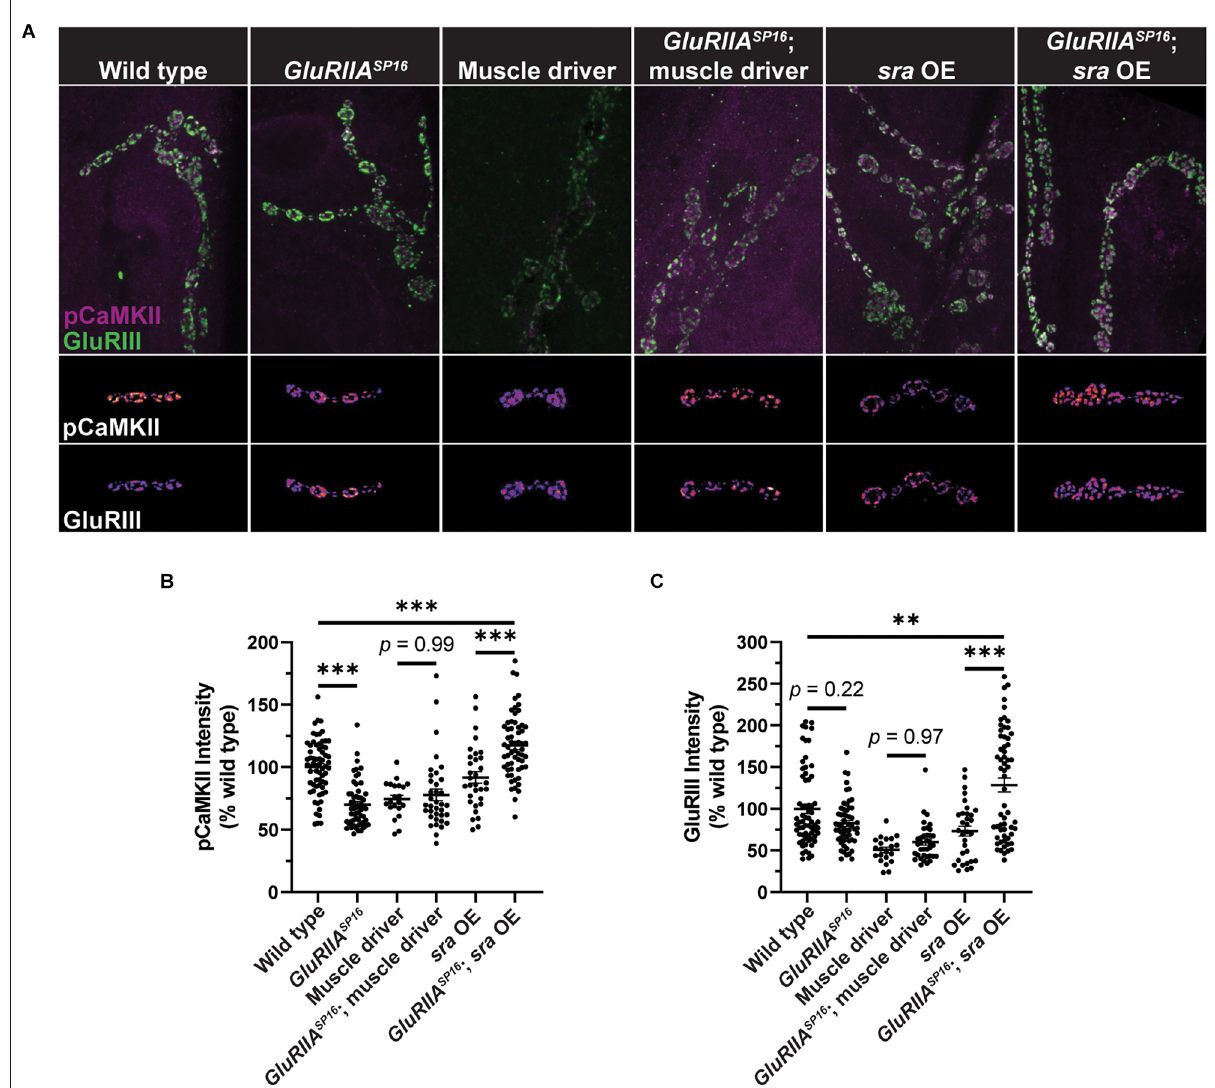
FIGURE6 Postsynaptic sra overexpression disrupts pCaMKII in Ib postsynaptic densities. (A) Maximum-intensity projections of pCaMKII (magenta) and GluRIII (green). Merged images of both channels are shown in the top row. Representative bouton maximum-intensity projections of pCaMKII (middle row) and GluRIII (bottom row) are shown as heat maps. (B) Quantification of pCaMKII intensity as a percentage relative to wild type boutons. Each point represents the intensity at an individual Ib postsynaptic density. (C) Quantification of GluRIII intensity as a percentage relative to wild type boutons. Ordinary one-way ANOVAs were used to compare each genotype followed by a Tukey’s HSD test for multiple comparisons. ∗∗ p < 0.01, ∗∗∗ p <